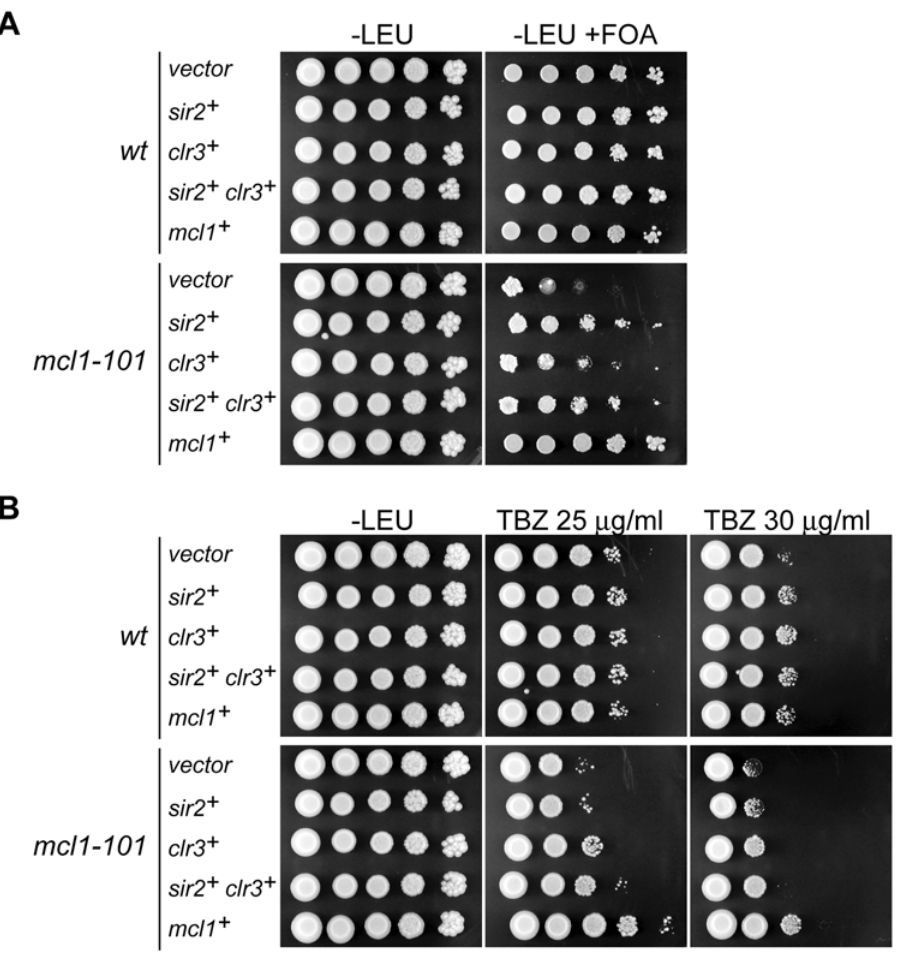
Figure 6. Multi-copy suppression of mcl1-101 phenotypes by sir2 + and clr3 + HDAC genes. Wild-type and mcl1-101 mutant harboring the ura4 + insertion at the cnt1 were transformed with multi-copy plasmid carrying sir2 + , clr3 + , or both, respectively. Tenfold serial dilutions were spotted onto EMM-Leu and EMM-Leu containing 5-FOA (A) or EMM-Leu containing indicated concentration of TBZ (B). In panel A, sir2 + and, to a lesser extent, clr3 + partially suppressed 5-FOA sensitivity of the mcl1-101 mutant. In panel B, clr3 + partially suppressed TBZ sensitivity of the mcl1-101 mutant, and sir2 + also relieved the sensitivity only in the presence of clr3 + .